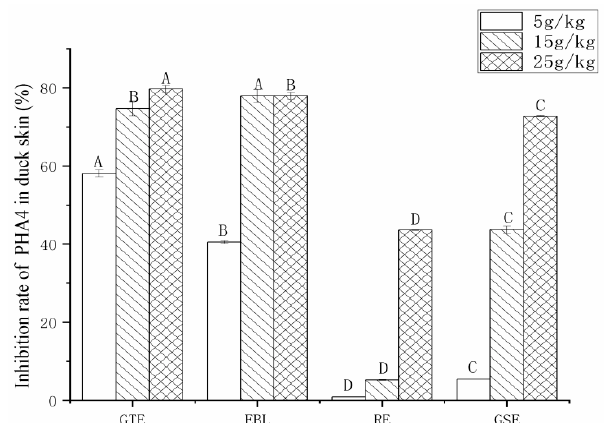
Figure 4. The total content of PAH4 in roast duck skin treated with four different extracts and three levels of addition. Note: GTE: pickling solution with green tea extract; EBL: pickling solution with extract of bamboo leaves; GSE: pickling solution with grape seed extract; RE: pickling solution with rosemary extract. Different letters (A, B, C and D) indicate significant differences comparison among extracts ( p < 0.05).